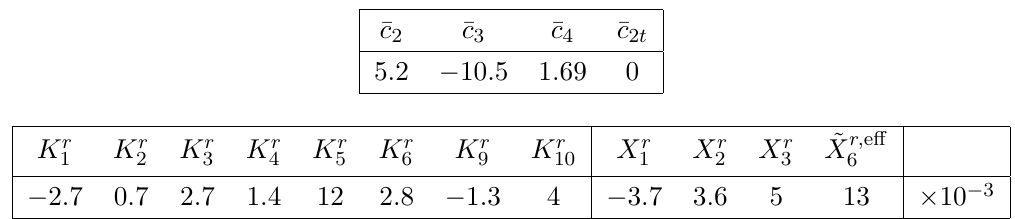
from [34]. Bottom: numerical (cid:0)